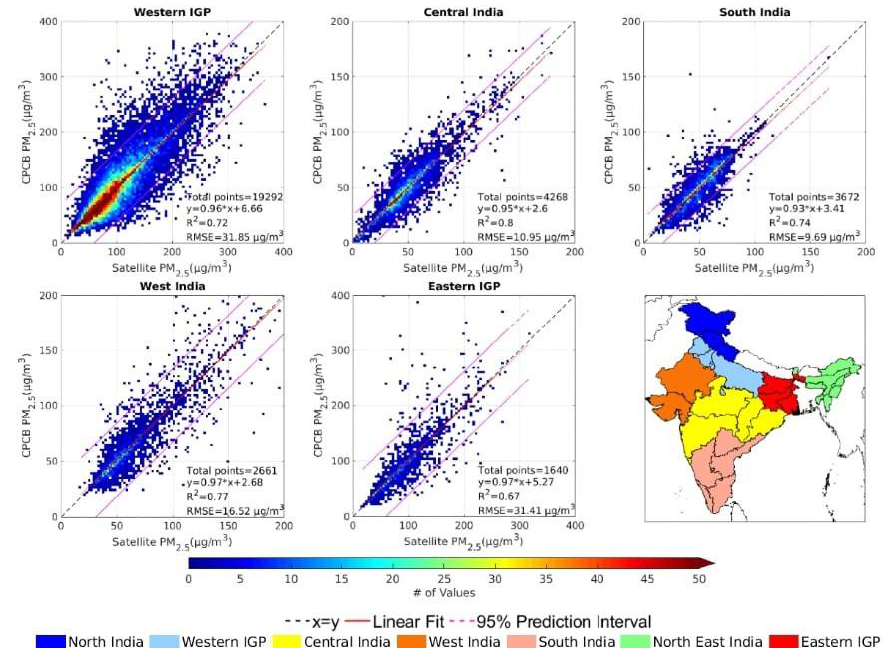
Figure A7. Regression statistics of the satellite-based daily PM 2.5 with measurements from CPCB sites for the various geographic regions (shown in the bottom right panel) over India. There are no ground-based monitoring sites in Northeast and North India to validate the retrieved PM 2.5.